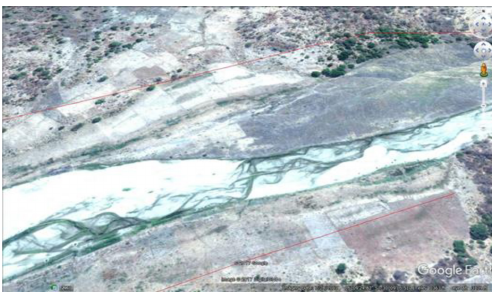
Figure 6. Flood extent polygon for 100 year return period at 30min timestep at